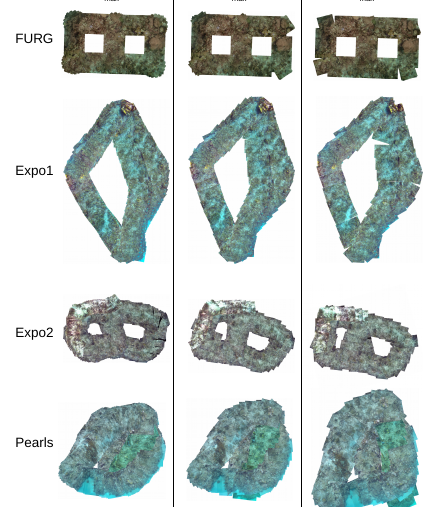
Figure 14. Obtained mosaics from applying our method to each